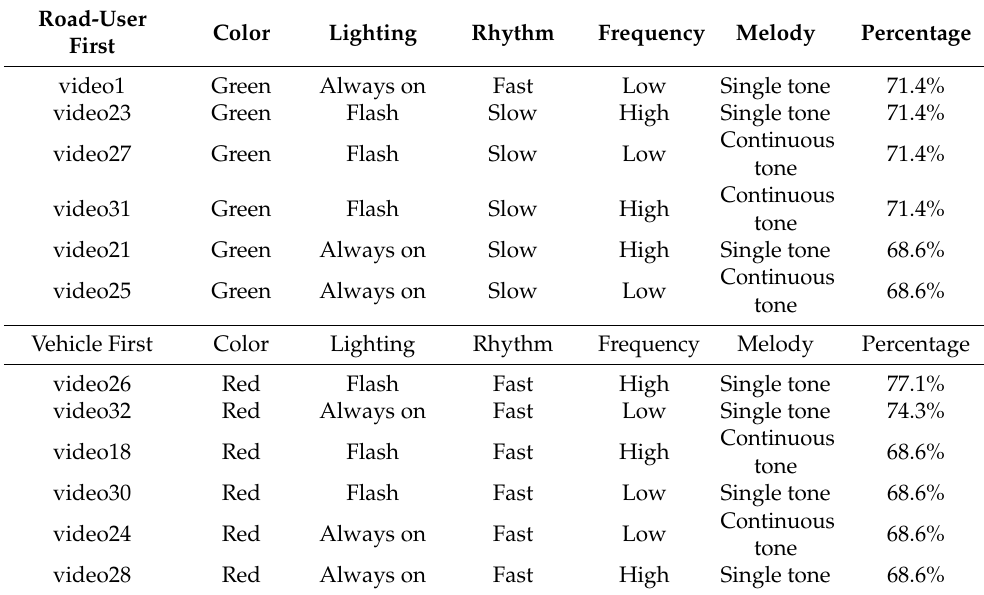
Table 3. Percentage of intention with different variable combinations for road-user first and vehicle first in deceleration scenario.